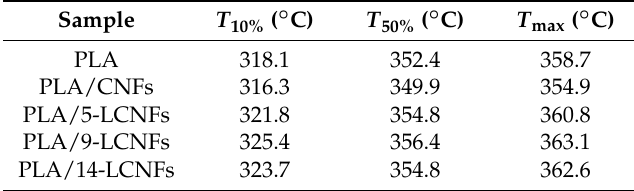
Table 2. Thermal degradation data of PLA/LCNFs composites with different lignin contents. Sample